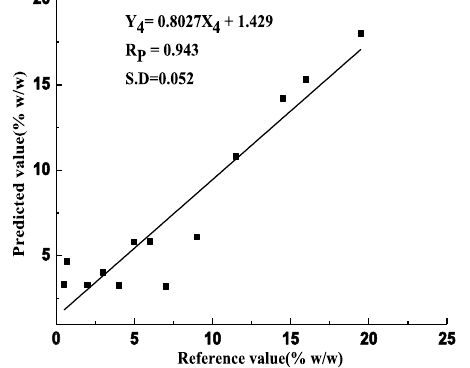
Fig. 5. Relationship of predicted values with the reference values of chlorpyrifos solutions by PLS with MSC. The straight line is obtained by linear